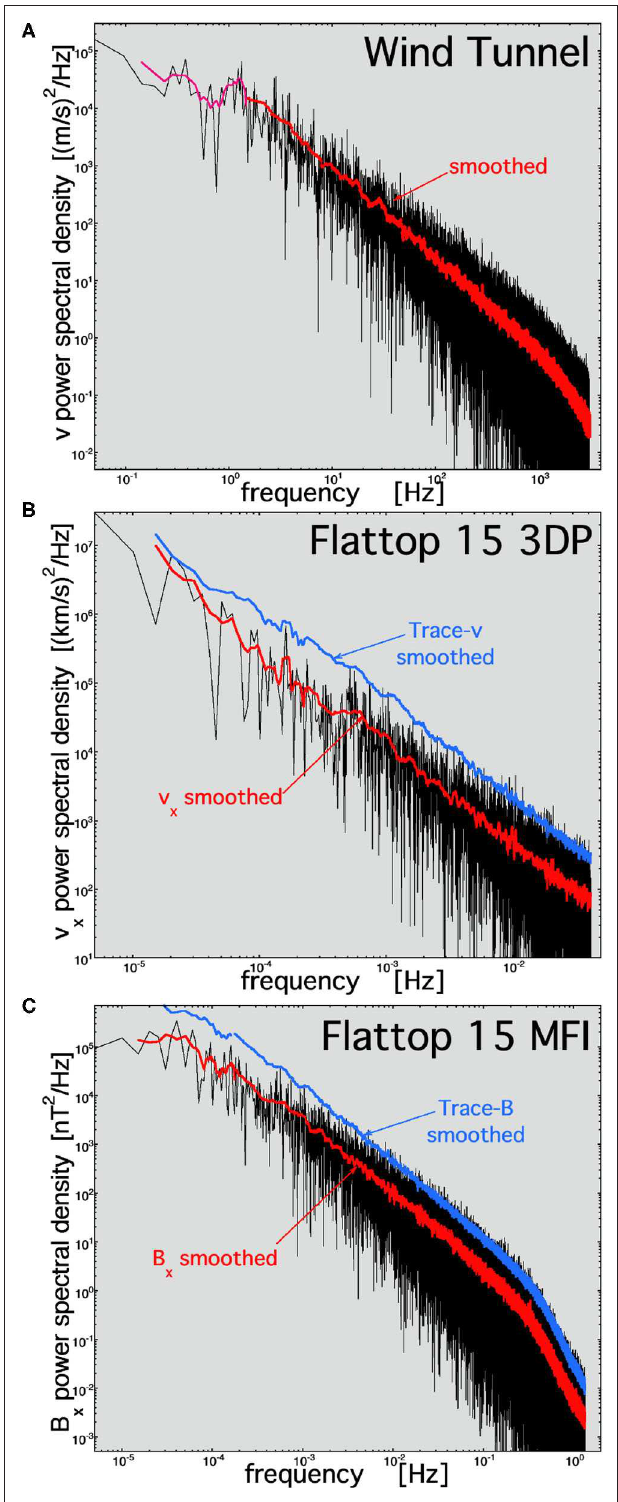
FIGURE 4 | Periodogram power spectral densities for (A) the streamwise velocity v in the wind tunnel Navier–Stokes turbulence, (B) the radial (from the Sun) velocity v x for the Alfvénic solar wind fluctuations of Flattop 15, and (C) the radial component of the magnetic field B x for the Alfvénic solar wind fluctuations of Flattop 15.